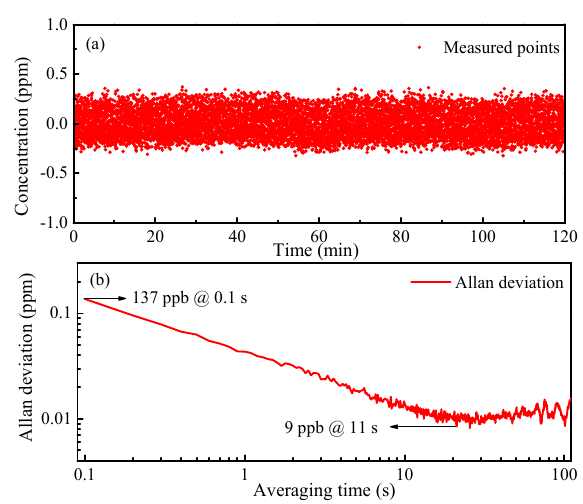
Figure 10. ( a ) Measured concentration of a 0 ppm C 2 H 2 sample; ( b ) Allan deviation analysis of the Figure 10. (a) Measured concentration of a 0 ppm C 2 H 2 sample, (b) Allan deviation analysis of the sensor system. sensor system.